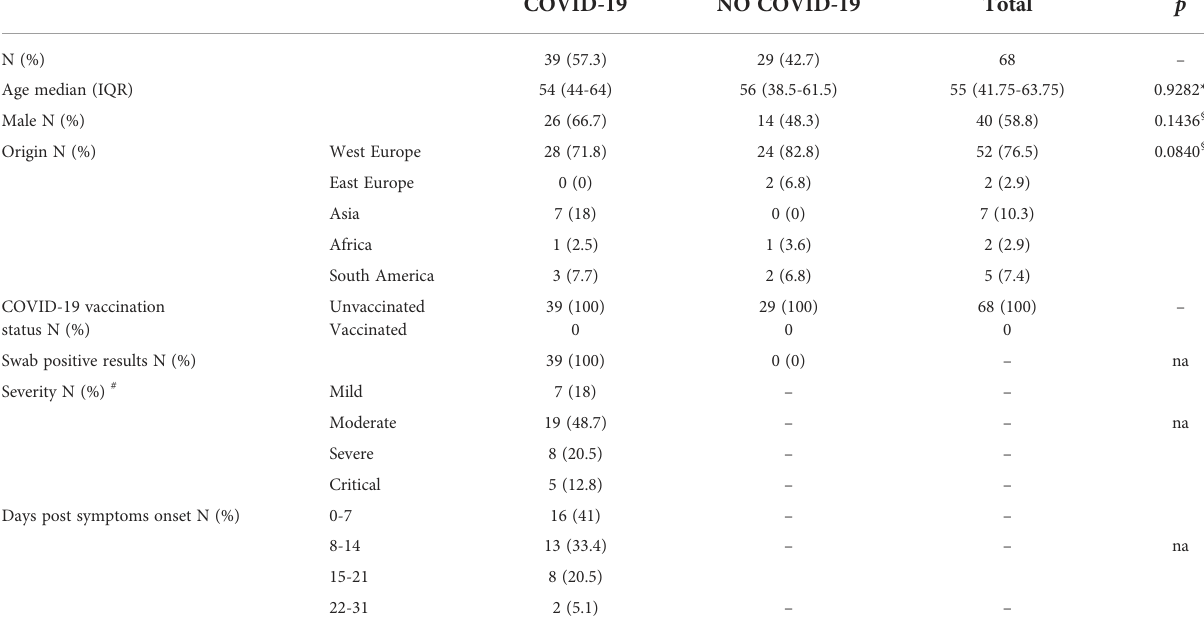
TABLE 1 Demographical and clinical characteristics of study population “ A ” for baseline evaluation of cytokines, chemokines, and growth factors in